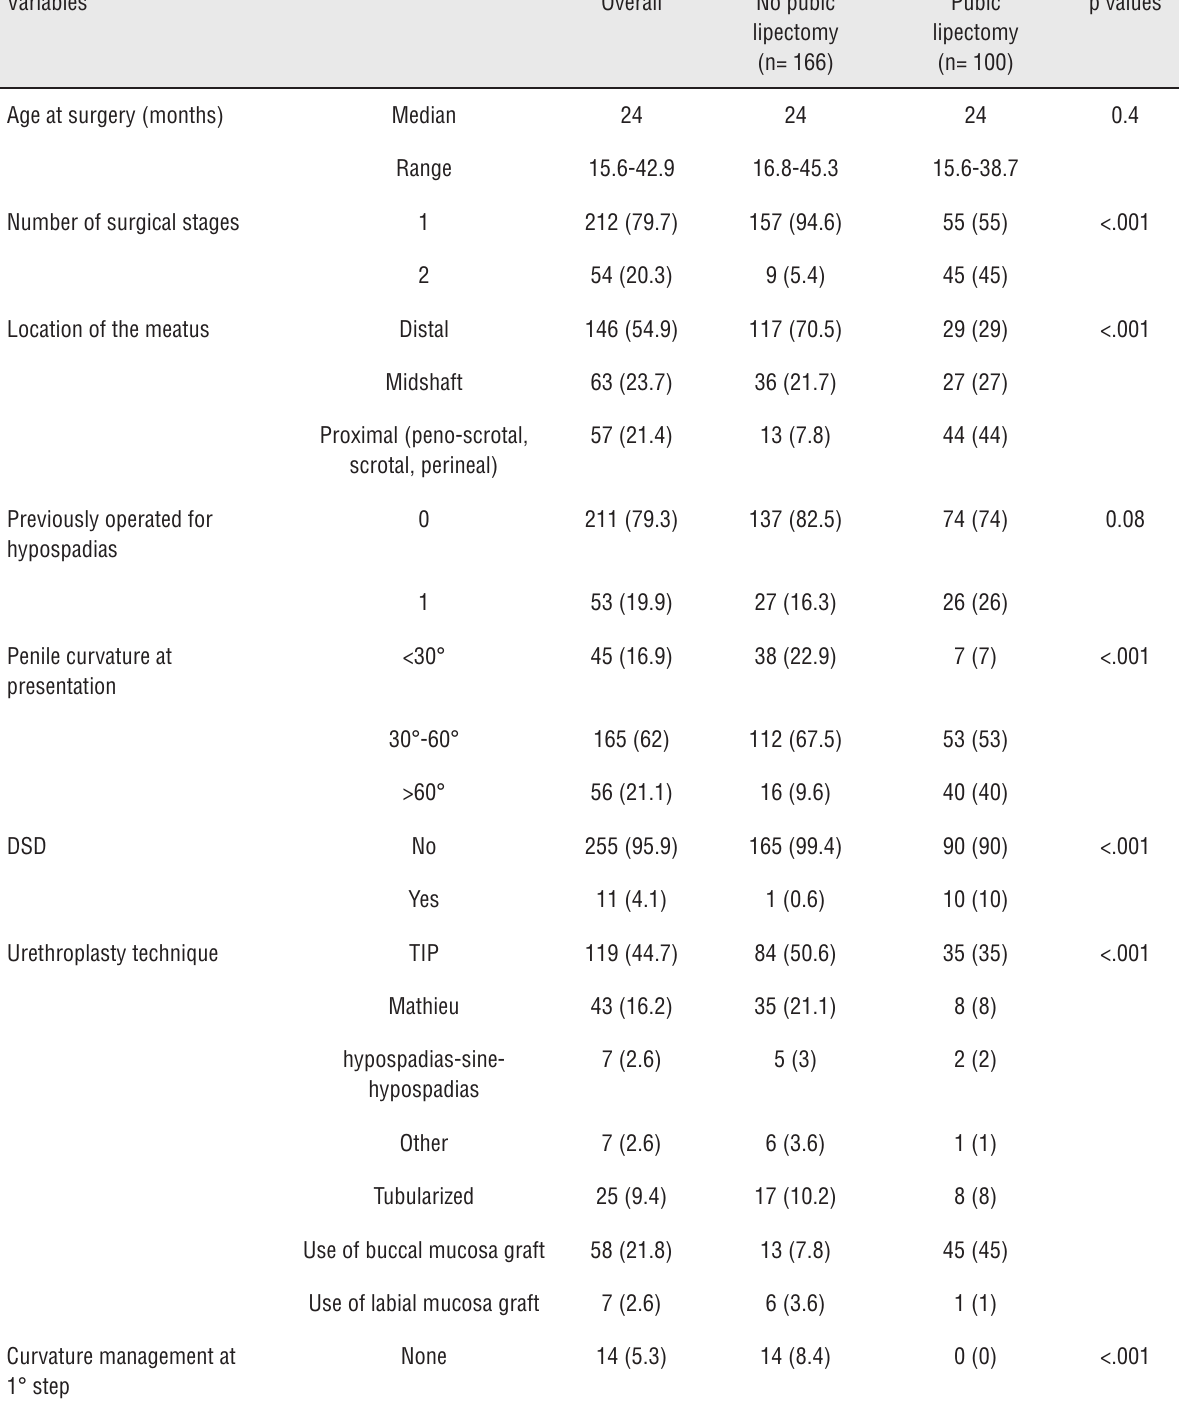
Table 1 - General patient characteristics of 266 individuals referred to our clinic for hypospadias, between January 2013 and April